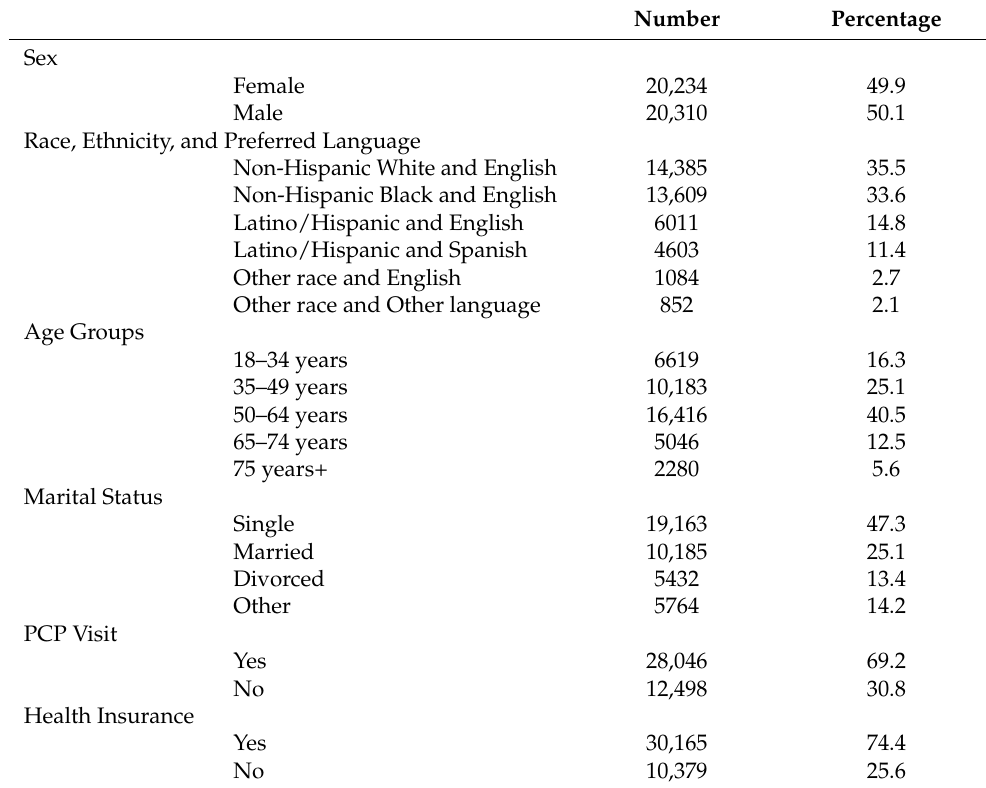
Table 1. Patient-level characteristics of adults with multimorbidity (N = 40,544), linked Electronic health records and American Community Survey Database, 2019–2020.